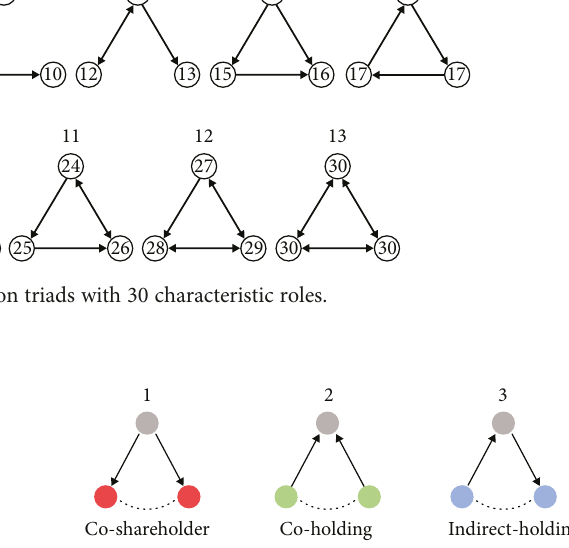
Figure 2: Three types of implied relationships among industries. Gray nodes represent intermediaries linking two nonconnected industries in triads. Dotted lines depict implied relationships between two nonconnected colored nodes (coshareholder relationship between red nodes in pattern 1, coholding relationship between green nodes in pattern 2, and indirect- holding relationship between blue nodes in pattern 3).